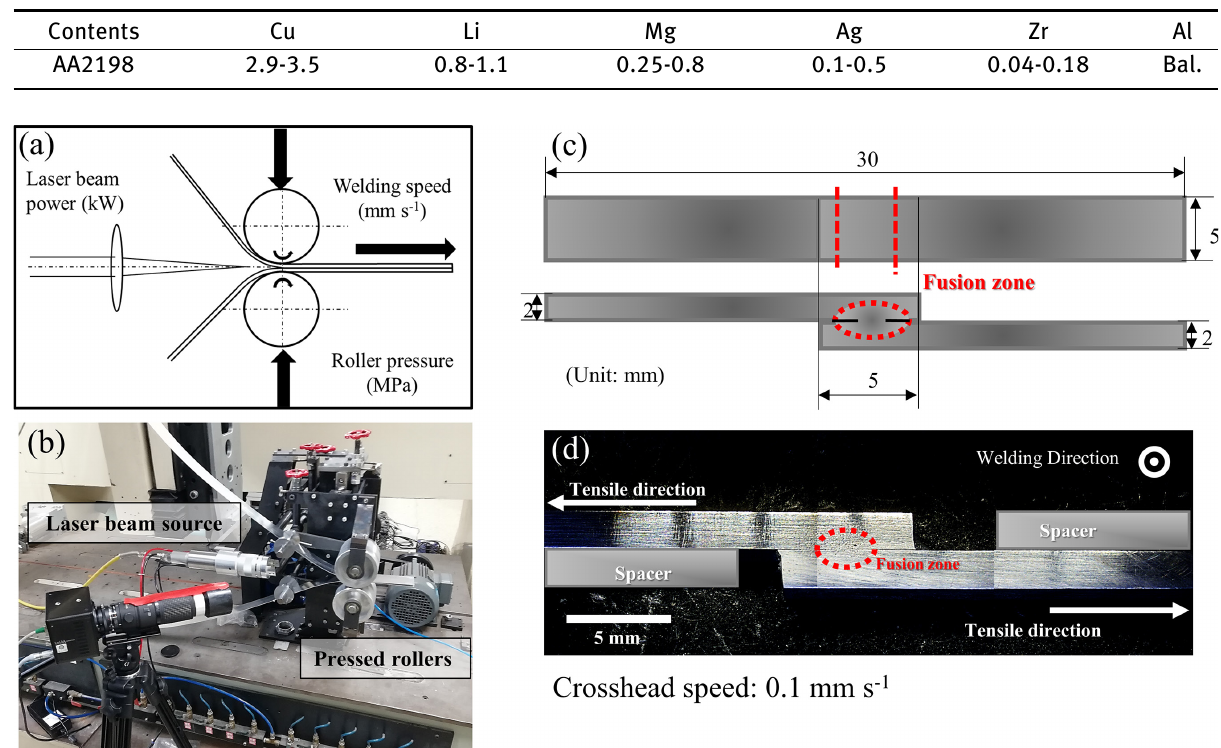
Figure 1: (a) Schematic illustration of laser pressure welding; (b) experimental set-up of laser pressure welding; (c) Configuration of speci- men for tensile shear test and (d) macroscopic picture of a tensile shear test